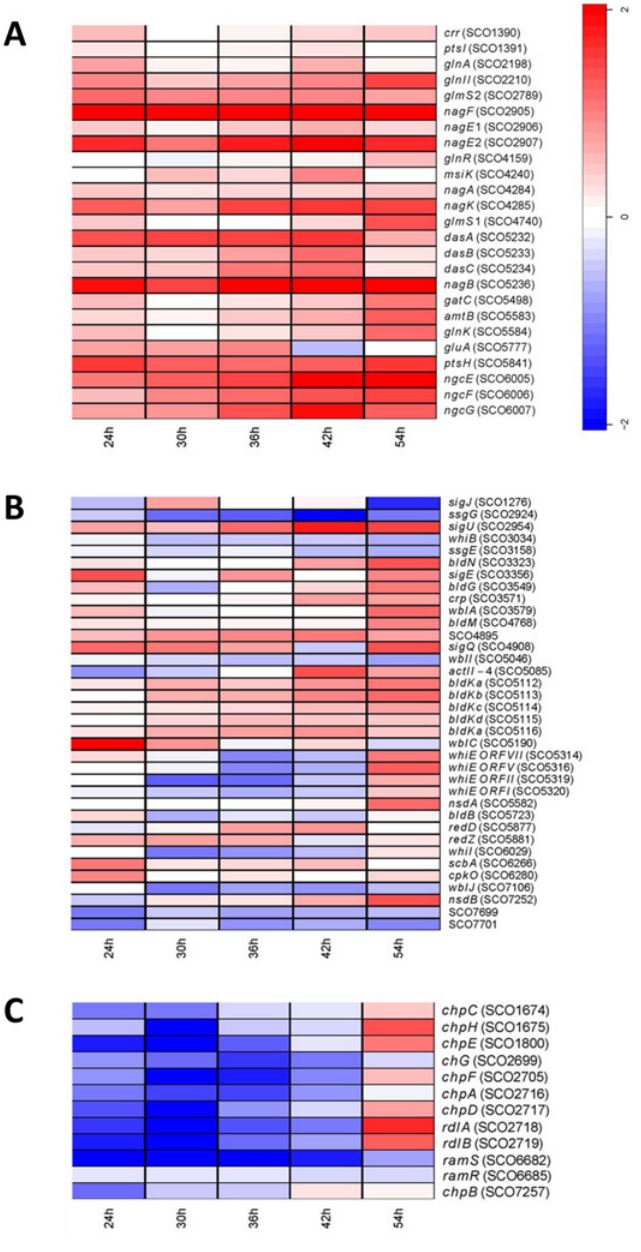
Fig 3. Selected categories of genes significantly differentially expressed in the dasR null mutant. Important categories of genes whose transcription was altered significantly in microarray experiments when comparing the dasR mutant GAM29 to its parent S . coelicolor M145 are shown; these are (A) genes for amino acid and (amino-)sugar transport and metabolism; (B) genes related to development and antibiotic production; (C) genes for chaplins, rodlins and SapB. RNA was isolated from S . coelicolor M145 or its dasR mutant GAM29 cultivated on MM mannitol agar plates after 24 h (vegetative growth), 30 h (vegetative/aerial growth), 36 h (aerial growth), 42 h (aerial growth/sporulation) and 54 h (sporulation). A heat map is provided as reference for the fold changes in log scale (log 2 (mutant/wild-type)).Note that many genes shown a larger than four-fold change in transcription. Some key genes that were experimentally validated DasR targets but with < 2-fold change are also presented. For exact values see S3